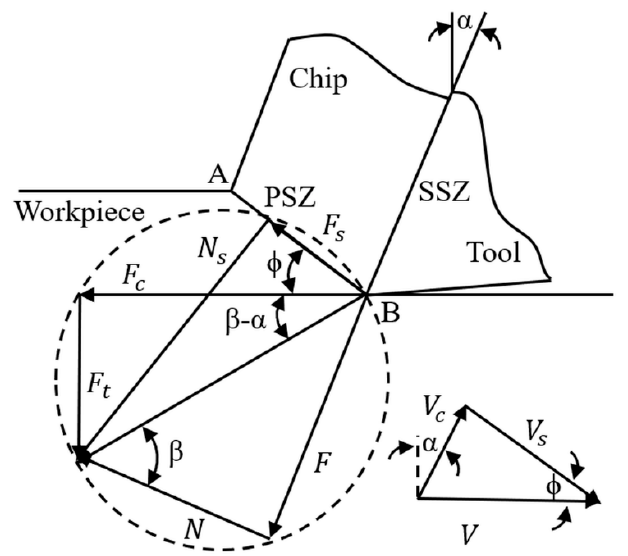
Figure 1. Schematic drawing of the orthogonal cutting process using a force circle. PSZ and SSZ denote the primary shear zone and secondary shear zone, respectively.